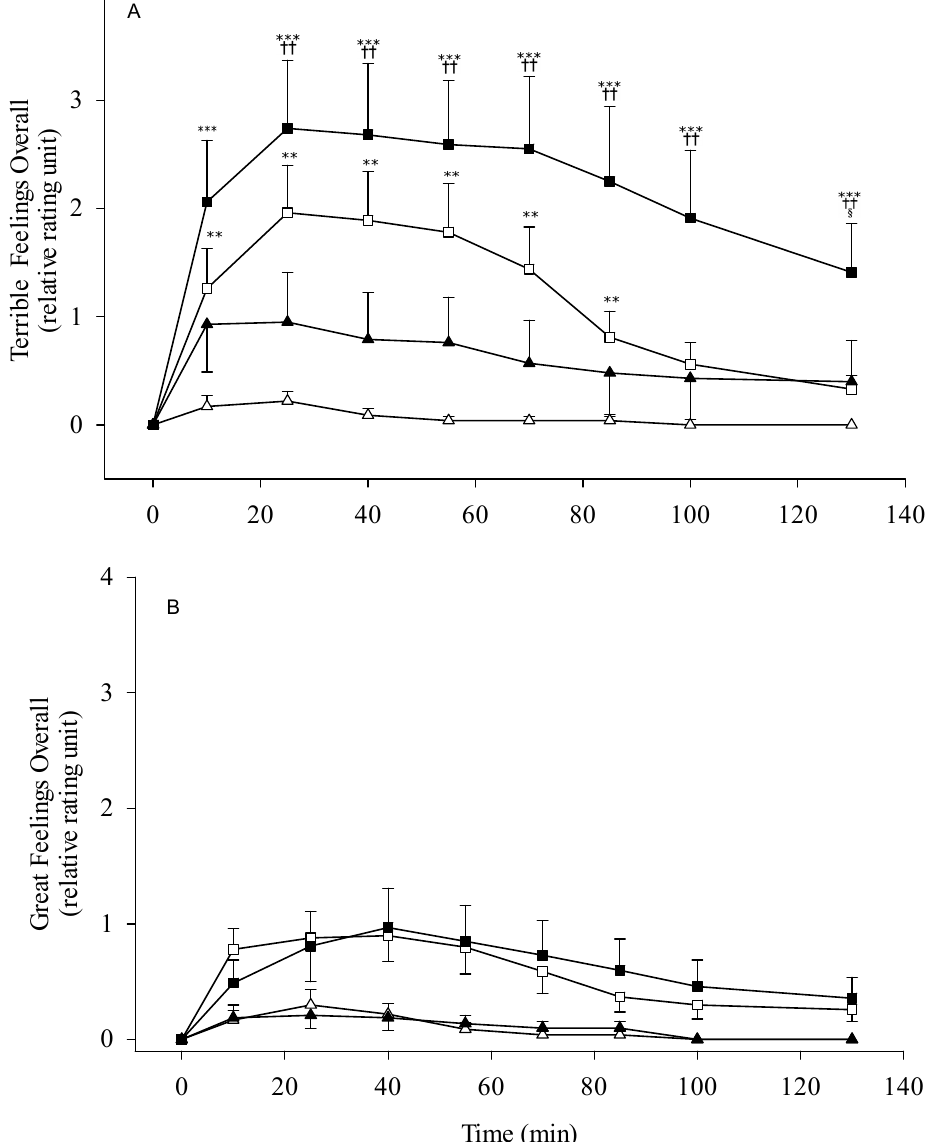
Figure 6. Overall terrible feelings ( A ) and great feelings ( B ) in nonalcoholic subjects with different ALDH2 allelotypes following different doses of ethanol (0.3 g/kg body weight or 0.5 g/kg). All subjects are ADH1B*2/*2 homozygote. The study groups are denoted as △ , ALDH2*1/*1 with 0.3 g/kg ethanol ( n = 23); ▲ , ALDH2*1/*1 with 0.5 g/kg ethanol ( n = 21); □ , ALDH2*1/*2 with 0.3 g/kg ethanol ( n = 27); ■ , ALDH2*1/*2 with 0.5 g/kg ethanol ( n = 22). Vertical bars (for clarity only the upper or lower portion shown) represent standard errors of the mean. Statistically significant differences between groups at the corresponding time points was evaluated by ANOVA. *** p < 0.001, ** p < 0.01 vs. ALDH2*1/*1 with 0.3 g/kg ethanol; ++ p < 0.01 vs. ALDH2*1/*1 with 0.5 g/kg ethanol; § p < 0.05 vs. ALDH2*1/*2 with 0.3 g/kg ethanol.